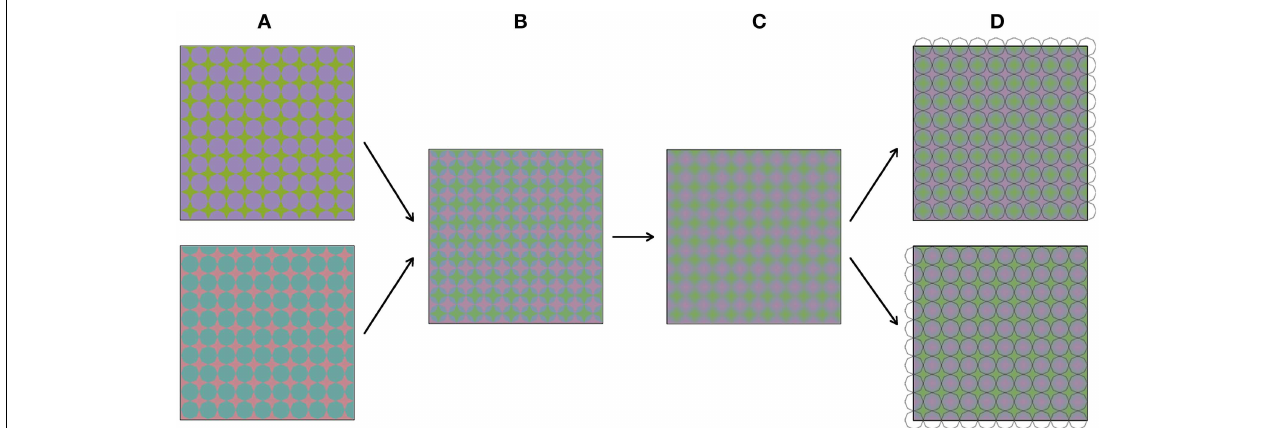
FIGURE 3 | (A–D) Visualize sequentially how the stimuli from Figure 2 were constructed.